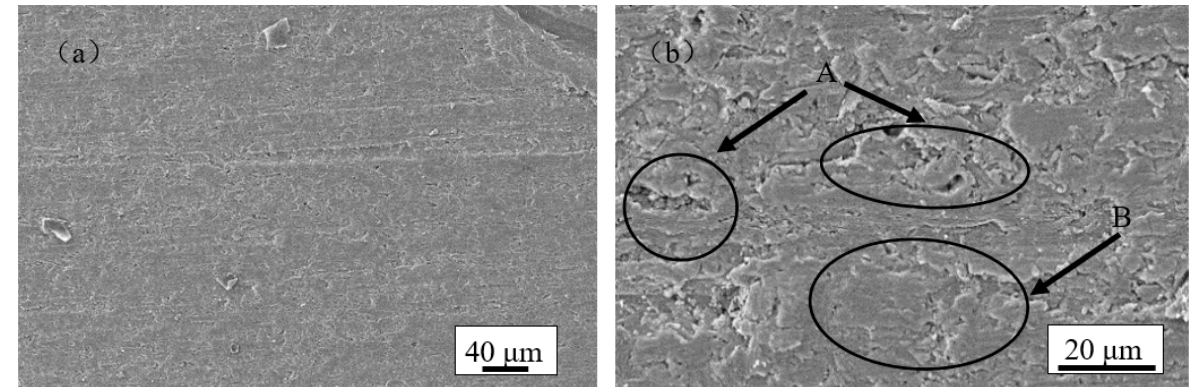
Figure 3. The microstructure of a two-layered gradient aluminum foamed cell wall under a scanning electron microscope at different scales with of ( a ) 40 μ m and ( b ) 20 μ m: A—gaps between particles, B—bent and interlocked boundary.